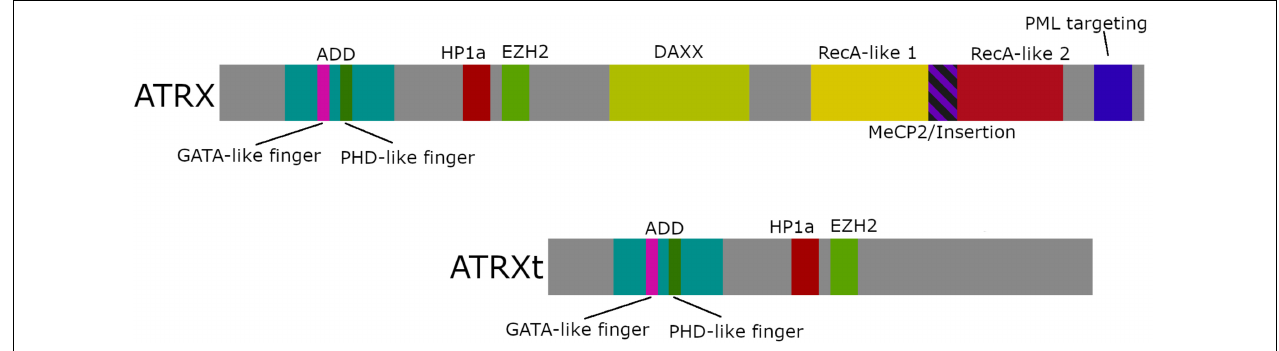
FIGURE 2 | ATRX domain structure. Schematic diagram of full-length ATRX (282 kDa), truncated ATRX (ATRXt; 180 kDa), and locations of the key protein interaction domains. The two isoforms share an ADD domain, a HP1 α binding motif, an EZH2 binding motif, while the ADD domain is comprised of a GATA-like zinc finger and a PHD-like zinc finger. The full-length polypeptide also contains a DAXX binding motif, a SNF2-ATPase domain comprising RecA-like lobes 1 and 2 separated by a linker region containing a MeCP2 binding motif (MeCP2/Insertion), and a PML targeting